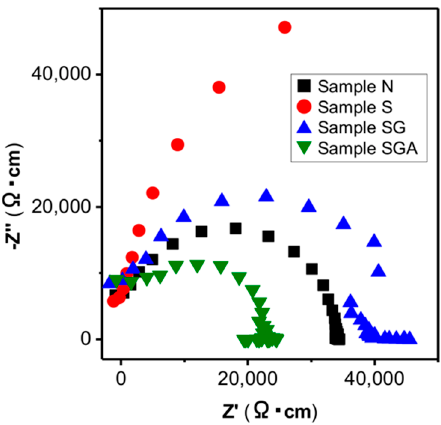
Figure 6. Nyquist plots of Samples N, S, SG and SGA.